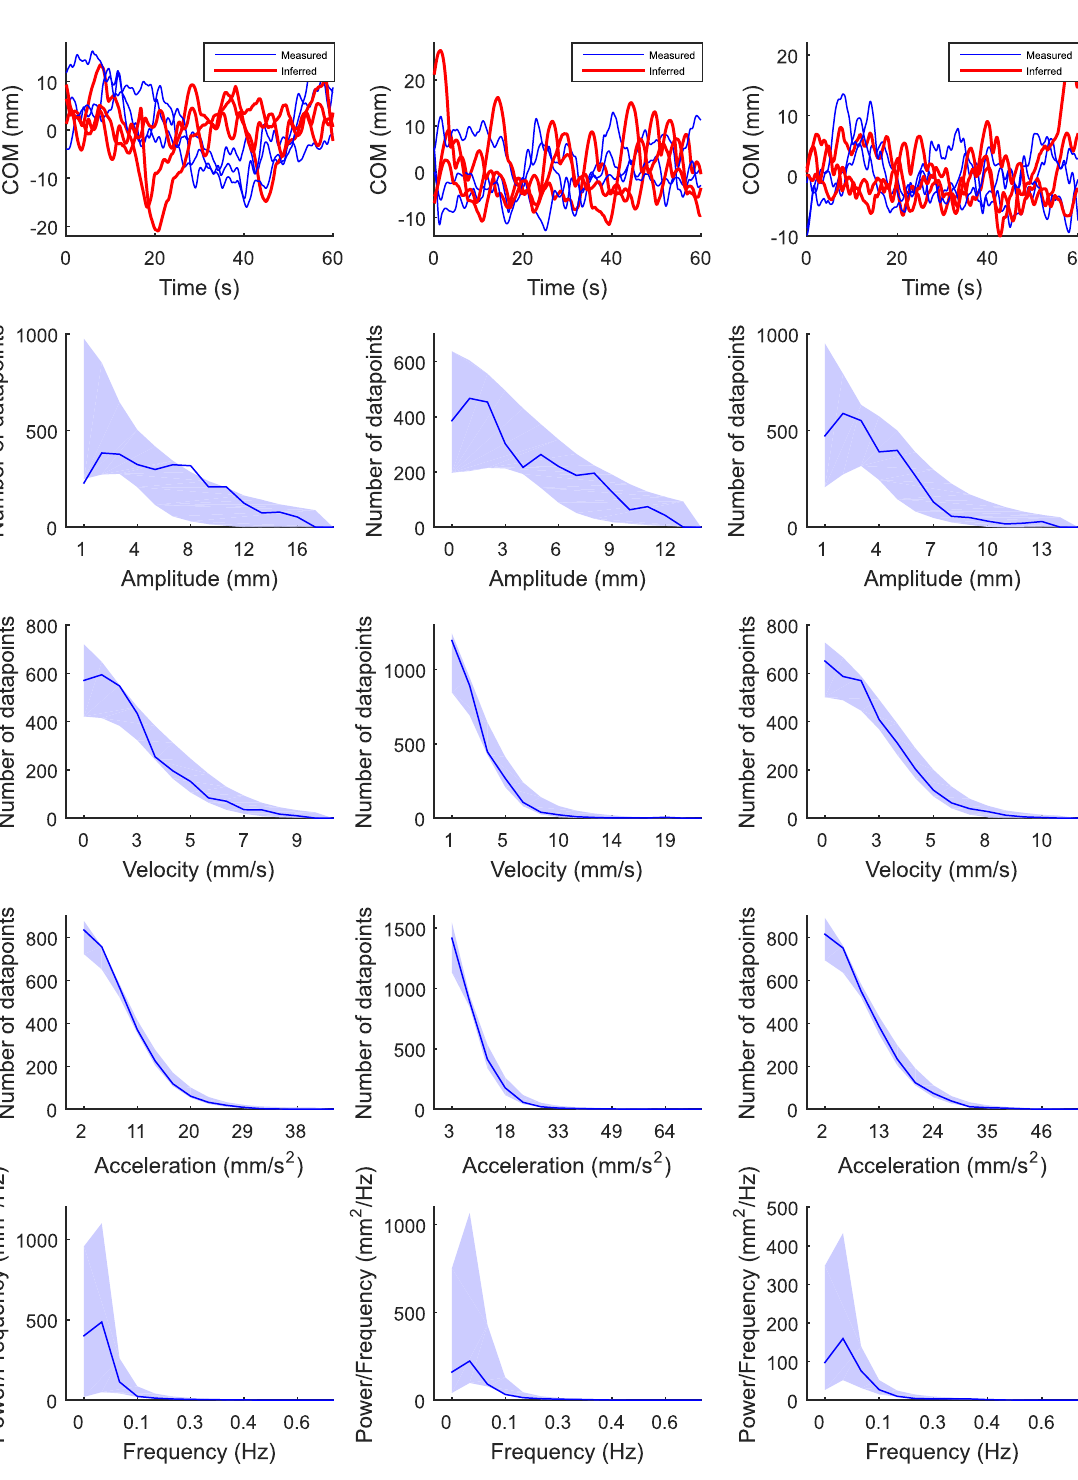
Figure 7. Real COM sway signals (top panel) and corresponding summary statistics (lower panels). The three columns present three real subjects. The blue COM curves correspond to the measured signals. The red COM signals represent values simulated using parameters that were sampled from the joint posterior PDFs that were inferred from the measured COM signals by the SMC-ABC algorithm. The lower panels show the summary statistics: amplitude -, velocity -, and acceleration histograms and spectra (see Section Methods: Statistical inference of the model parameters). In each figure, the blue line is the true summary statistic calculated from the original COM signals, and the blue shadowed regions present 95% CIs that were calculated using the COM signals that were simulated using parameters that were sampled from the inferred marginal posterior PDFs. The mass and estimated height of COM (see Section Methods: The control model) are: leftmost column: m = 68 kg and h = 0.80 m; mid column: m = 66 kg and h = 0.89 m; rightmost column: m = 68 kg and h = 0.87